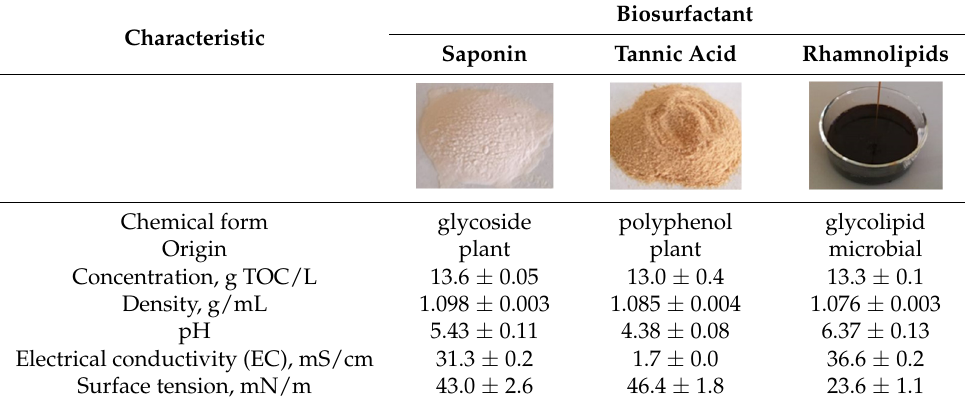
Table 2. Selected characteristics of aqueous solution of biosurfactants (mean ± SD, n = 3). Characteristic